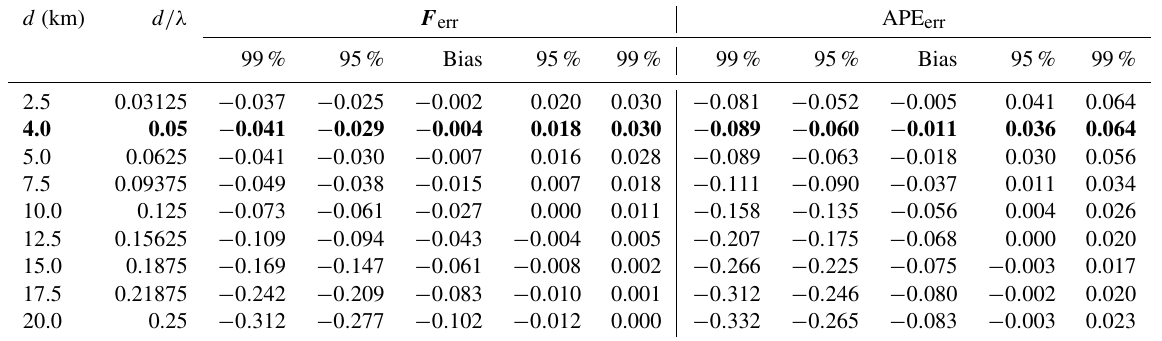
Figure 8. Histograms of (a) energy flux relative error and (b) APE relative error due to mis-sampling density in an idealized M 2 multi-mode internal tide field for the four watch circle diameter cases shown in Fig. 6. Positive error indicates an overestimation and negative error indicates an underestimation. Distribution of (a) energy flux relative error and (b) APE relative error against watch circle diameter, including the 99% and 95% confidence limits and the bias (median value). The four cases in panels (a) and (b) are indicated with black and grey triangles. The red triangle is the case most appropriate for the observations. The white triangles are four additional cases. Table 2. Distributions of energy flux relative error ( F err ) and APE relative error (APE err ) for all nine watch circle diameter cases. d/λ is watch circle diameter to mode-1 horizontal wavelength ratio. Positive error indicates an overestimation and negative error indicates an underestimation. The case most appropriate for the observations ( d/λ = 0 . 05) is in bold. d